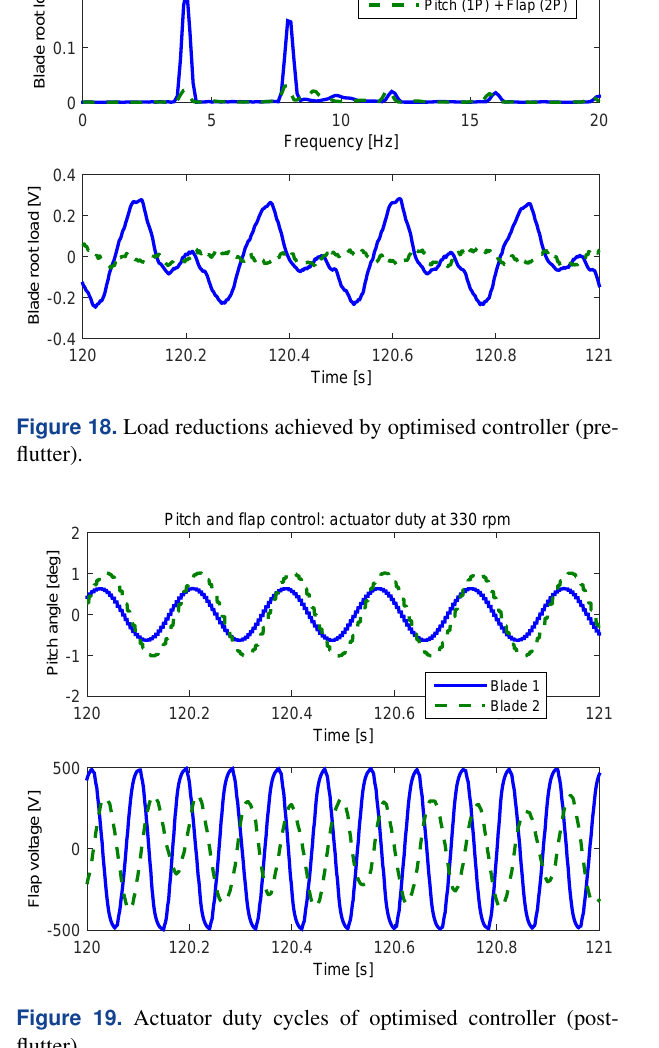
Figure 21. Varying operational speed for optimisation of gain